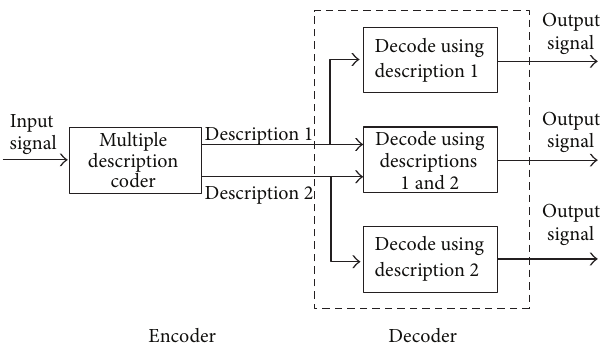
Figure 1: Multiple descriptions coding